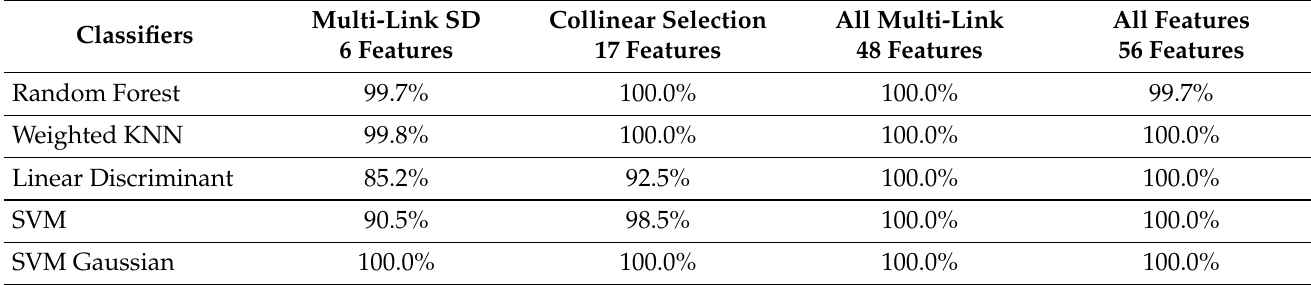
Table 9. Accuracy rates for models with multi-link